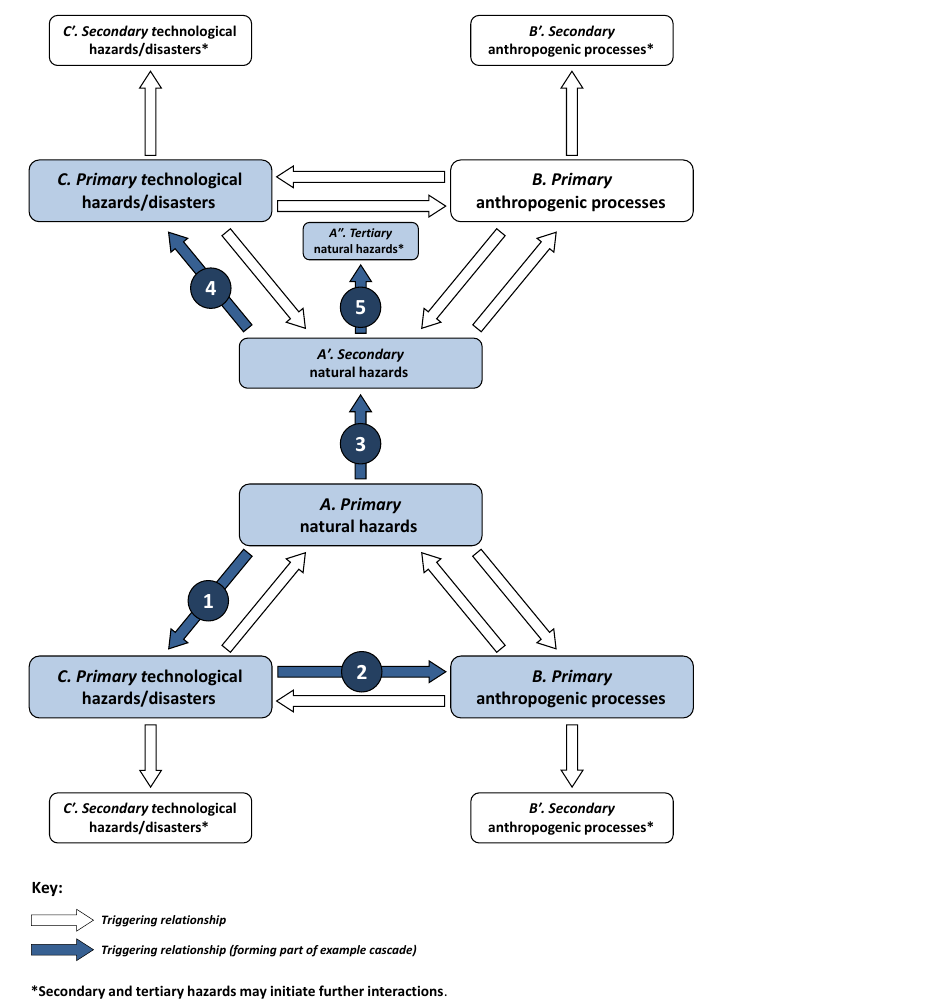
Figure 7. Network of hazard interactions (example B) using a hazard/process flow diagram. Using the visualisations constructed in Figs. 2 and 3, an example of an interaction network (cascade) can be presented. In this example the network is more complex than in example A (Fig. 6), with three branches and five interaction relationships highlighted here. Three hazard/process groups are included: (A) natural haz- ards, (B) anthropogenic processes and (C) technological hazards/disasters. Arrows are used to illustrate interaction relationships, with both triggering relationships (thick block arrows with solid outlines) and relevant catalysing/impedance relationships (thin block arrows with dashed outlines). For clarity of communication, those catalysing/impedance relationships not of relevance to the specific example are not included. See caption explanations in Figs. 2 and 3 for further details. Arrows within the example network of hazard interactions are labelled (1–5) and shaded dark blue to highlight the relevant pathway. This example shows a primary natural hazard triggering (1) a primary tech- nological hazard, which in turn triggers (2) a primary anthropogenic process. The same primary natural hazard may trigger (3) a secondary natural hazard. This secondary natural hazard could then trigger (4) a primary technological hazard and (5) tertiary natural hazards.